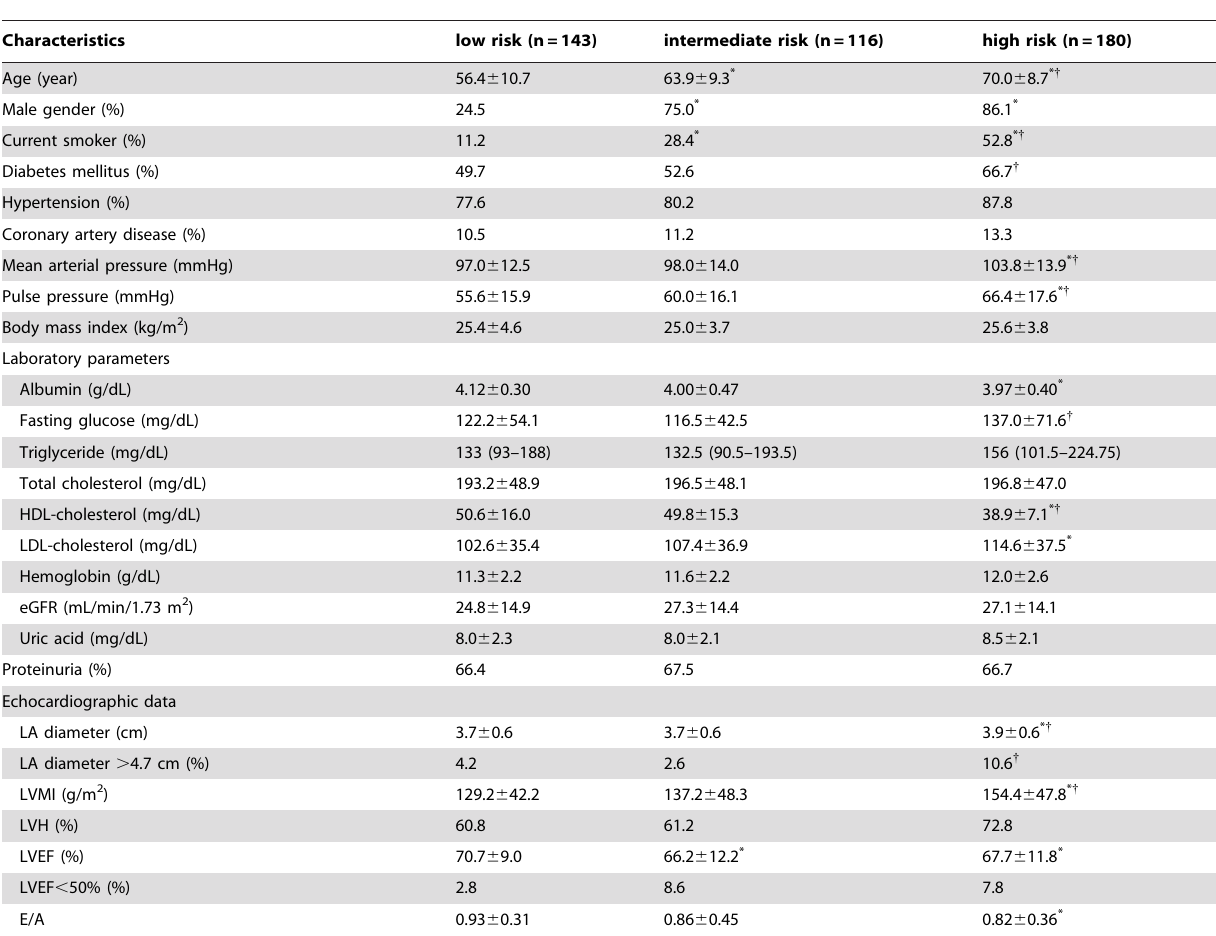
Table 1. Comparison of baseline characteristics among patients with different FRS category.